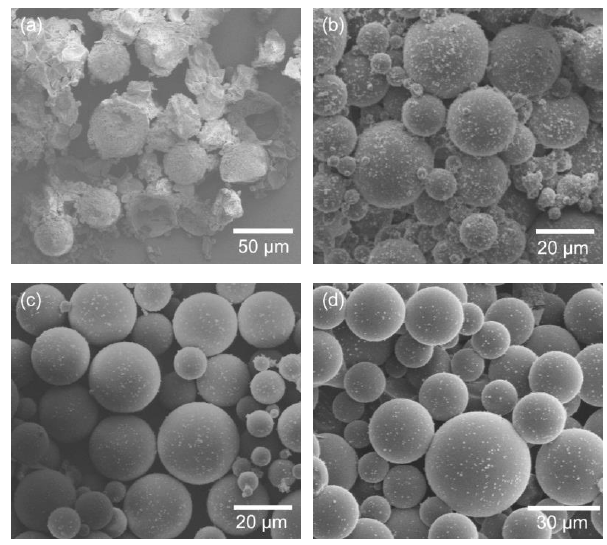
Figure 5. SEM images of n -hexadecane-encapsulated capsules obtained under an emulsification speed of 3000 rpm and a polymerization time of 2 h using different volumes of EMA as surfactant: ( a ) 15, ( b ) 20, ( c ) 28, and ( d ) 35